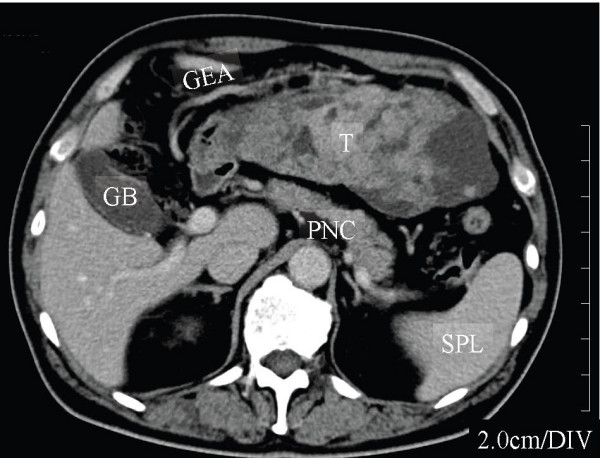
Computed Tomography. A huge tumor behind the left hepatic lobe showed heterogeneous low density with faint enhancement. GB, gallbladder; GEA, gastroepiploic artery; T, tumor; PNC, pancreas; SPL, spleen.